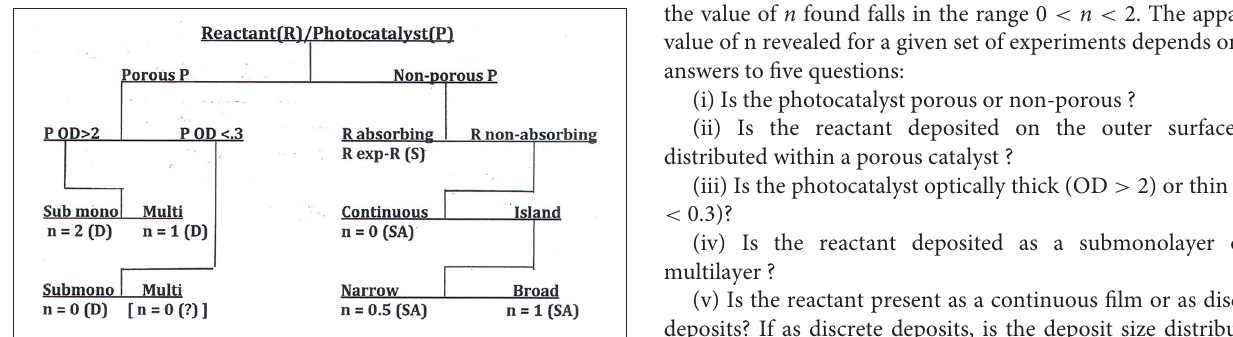
FIGURE 6 | A decision tree for determination of reaction order, n, for the photocatalyzed removal of deposits from surfaces. P, photocatalyst; R, reactant; D, dye; SA, stearic acid; S, soot (Ollis, in press).